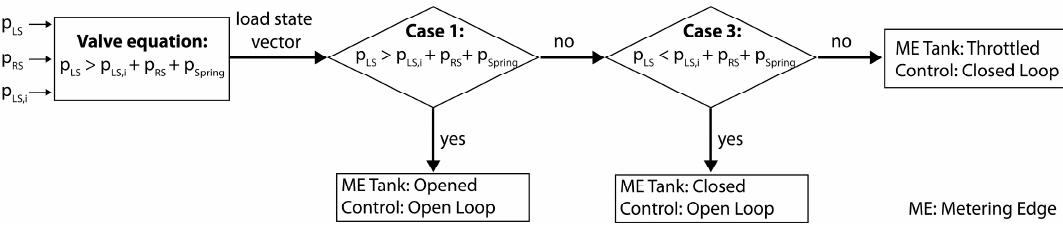
Figure 10. T/A-LV Logic Chart (see also [16]).